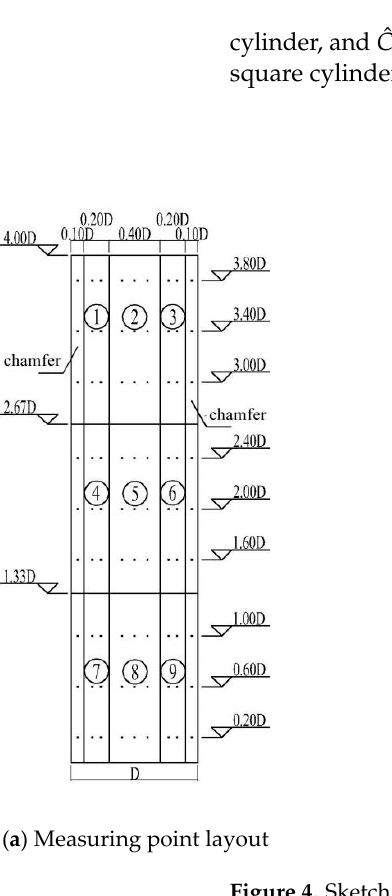
Figure 4. Sketch of tapping location and blocking region of facade. Considering that the distribution of corner cutting points is lower, the use of BIF cannot accurately describe the distribution law of corner interference. Therefore, the wind pressure coefficient interference factor IF of measuring points is further used for